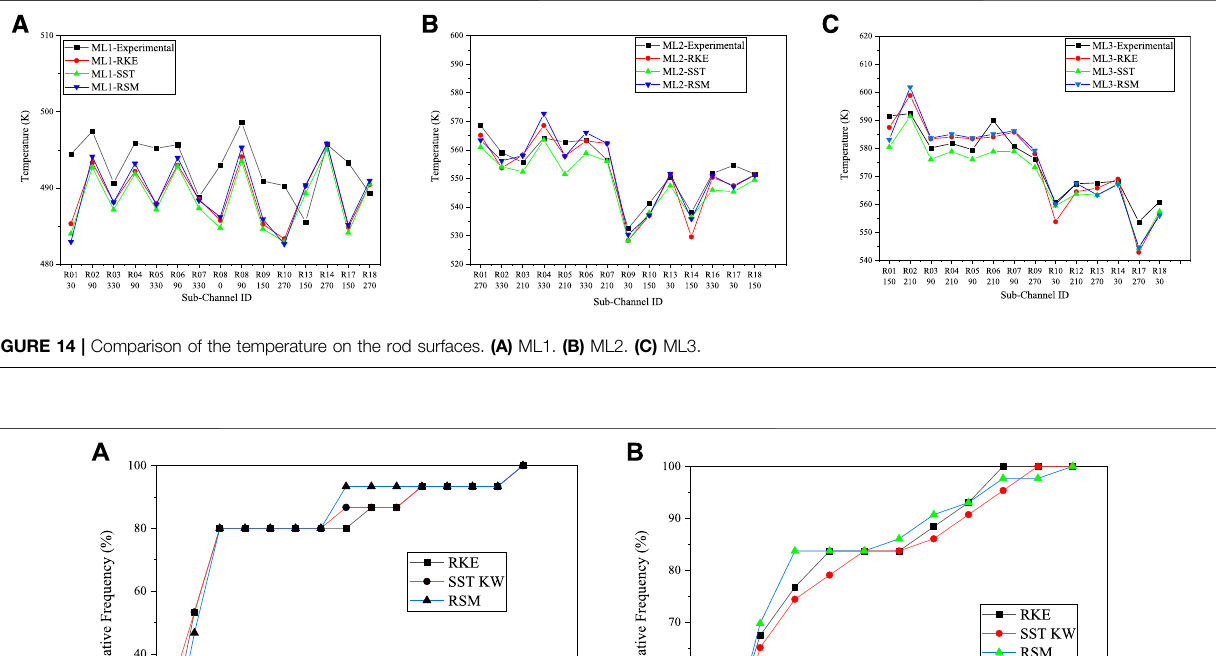
Frontiers in Energy Research |